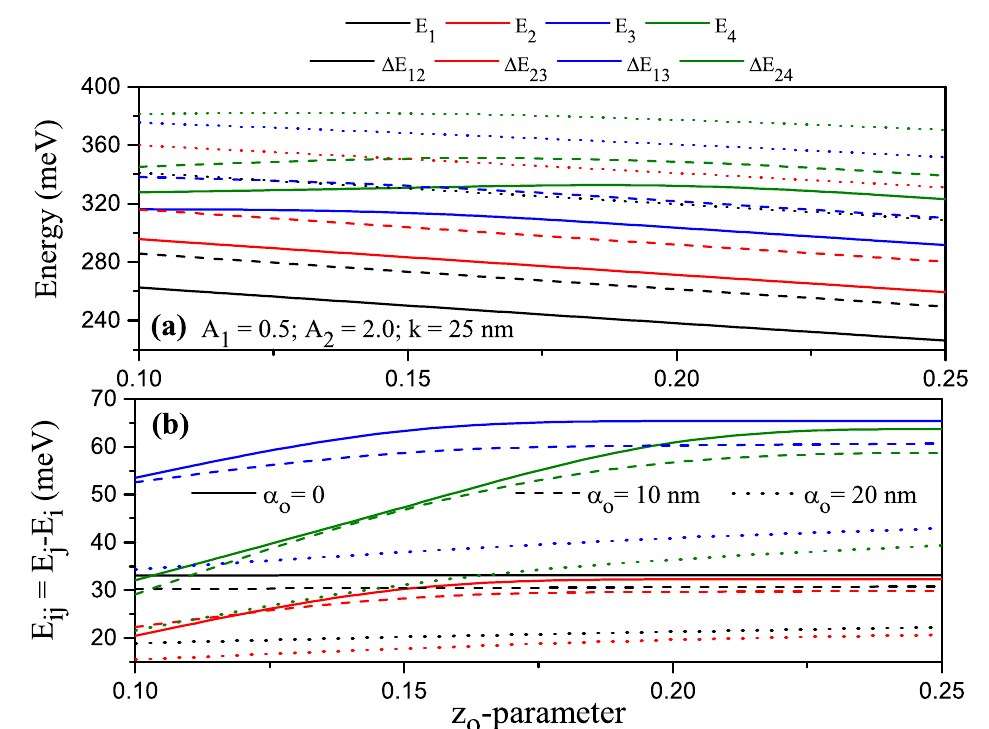
Figure 7. For A 1 = 0.5 and A 2 = 2.0 and k = 25nm, ( a ) variations in the first four lowest energy levels of the electron confined within parabolic–Gaussian asymmetric DQW under an intense laser field with respect to the z o parameter; ( b ) variation in energy differences between some levels versus the z o parameter. Solid, dashed, and dotted curves are for α o = 0, α o = 10nm, and α o = 20nm,